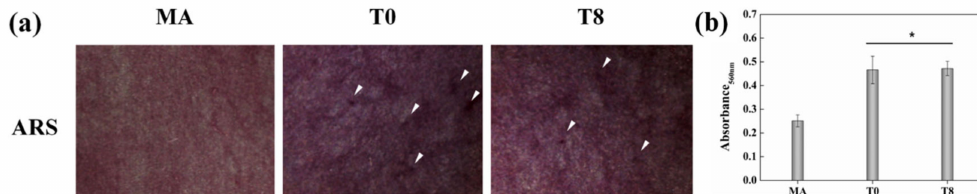
Figure 7. Extracellular matrix mineralization of osteoblasts on the specimens for 21 d assessed by Alizarin red S (ARS) staining. ( a ) Optical images (arrows indicate nodules) and ( b ) colorimetric quantitative analysis (* p < 0.05 vs.